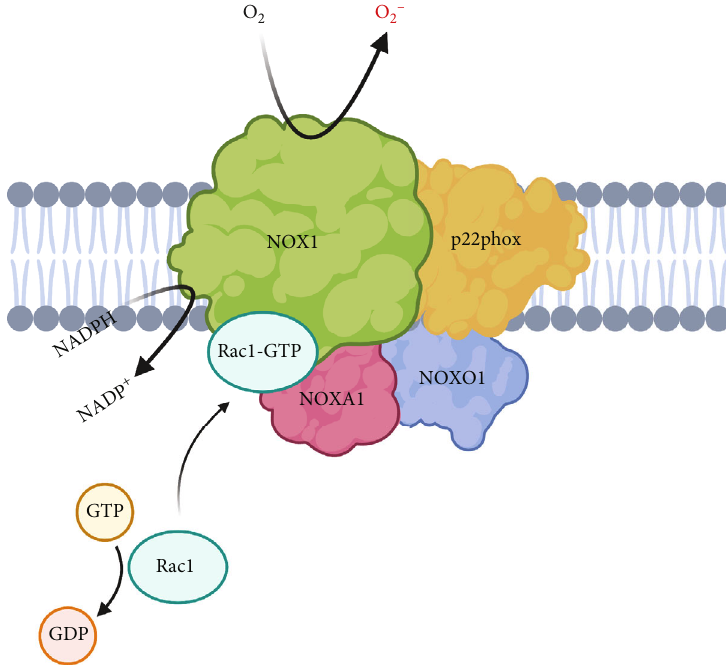
Figure 3: Proposed structure of the NOX1 complex consisting of NOX1, p22phox, GTP-bound Rac1, NOXA1, and NOXO1. p22phox and other subcellular subunits are assembled to activate catalytic subunit NOX1 which results in the generation of O [17]. Created with